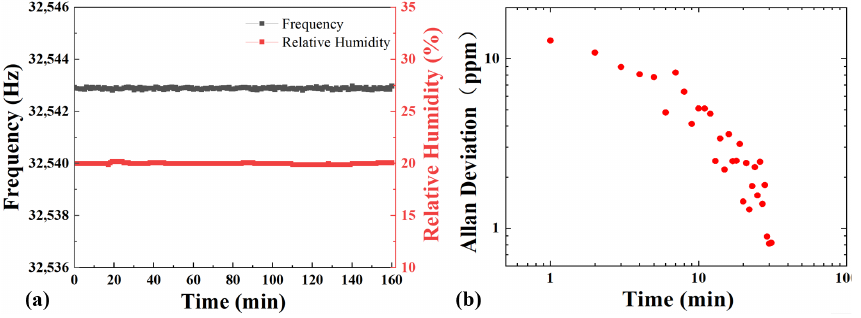
Figure 5. ( a ) Resonance frequency of the SSM-QTF and relative humidity measured for 160 min with the relative humidity controlled to be ~20% RH. ( b ) Allan deviations obtained by the SSM-QTF-based QECS systems.